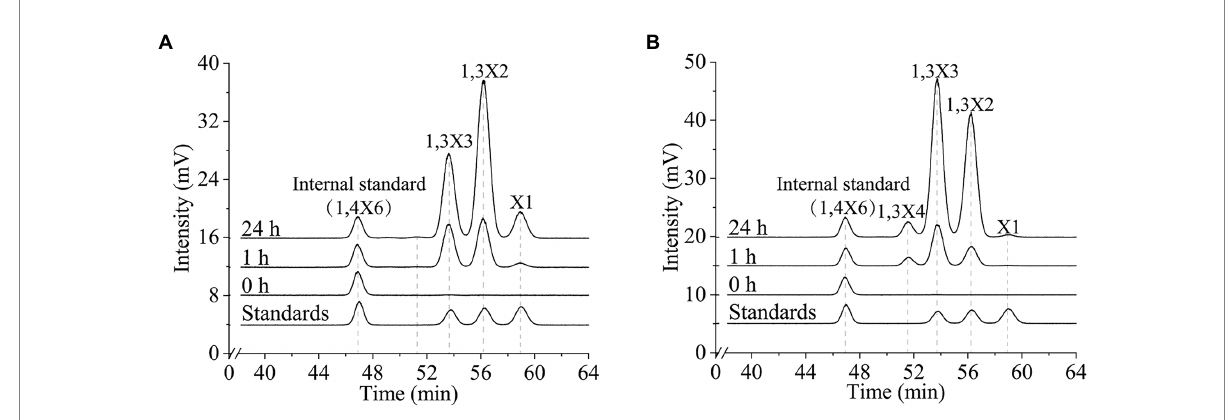
FIGURE 6 Time-course analysis of the 1,3-xylan degradation by recombinant 1,3-xylanases Xyn65 (A) and Xyn80 (B) . Xyn65 and Xyn80 were separately incubated with 1,3-xylan at 40 ° C in PBS (pH 7.0). At 0 h, 1 h and 24 h, the reaction was terminated by boiling for 5 min and the products were analyzed by HPLC-ELSD. A mixture of xylose, 1,3-xylobiose (1,3X2) and 1,3-xylotriose (1,3X3) was used as the external standard. 1,4-xylohexaose (1,4X6) was used as the internal standard. The data are representatives of the results of triplicate